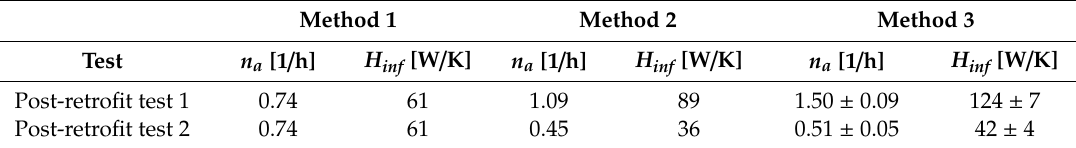
Table 6. Infiltration rates and related heat losses—calculated for di ff erent